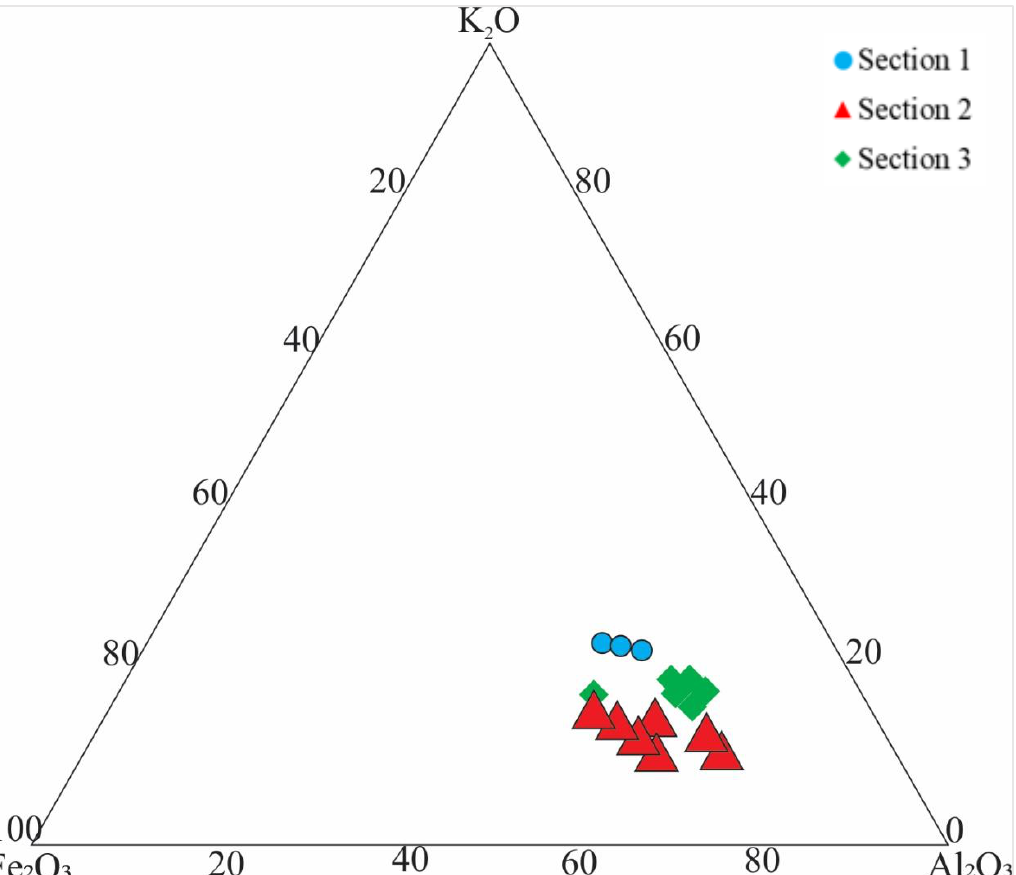
Figure 7. The plot of La/Sc vs. Th/Co for Chichali Formation shale.